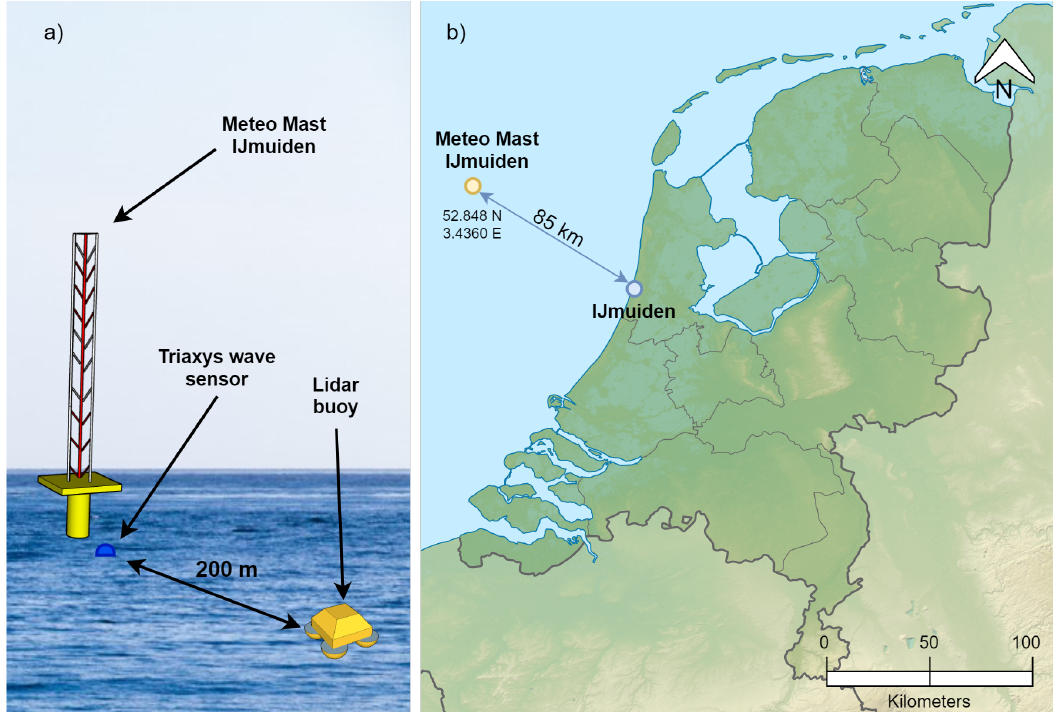
Figure 1. IJmuiden test campaign: ( a ) experiment setup at IJmuiden’s test showing the lidar buoy prototype test Doppler wind lidar (DWL) buoy and reference meteorological mast (metmast), adapted from [26], and ( b ) location map adapted from